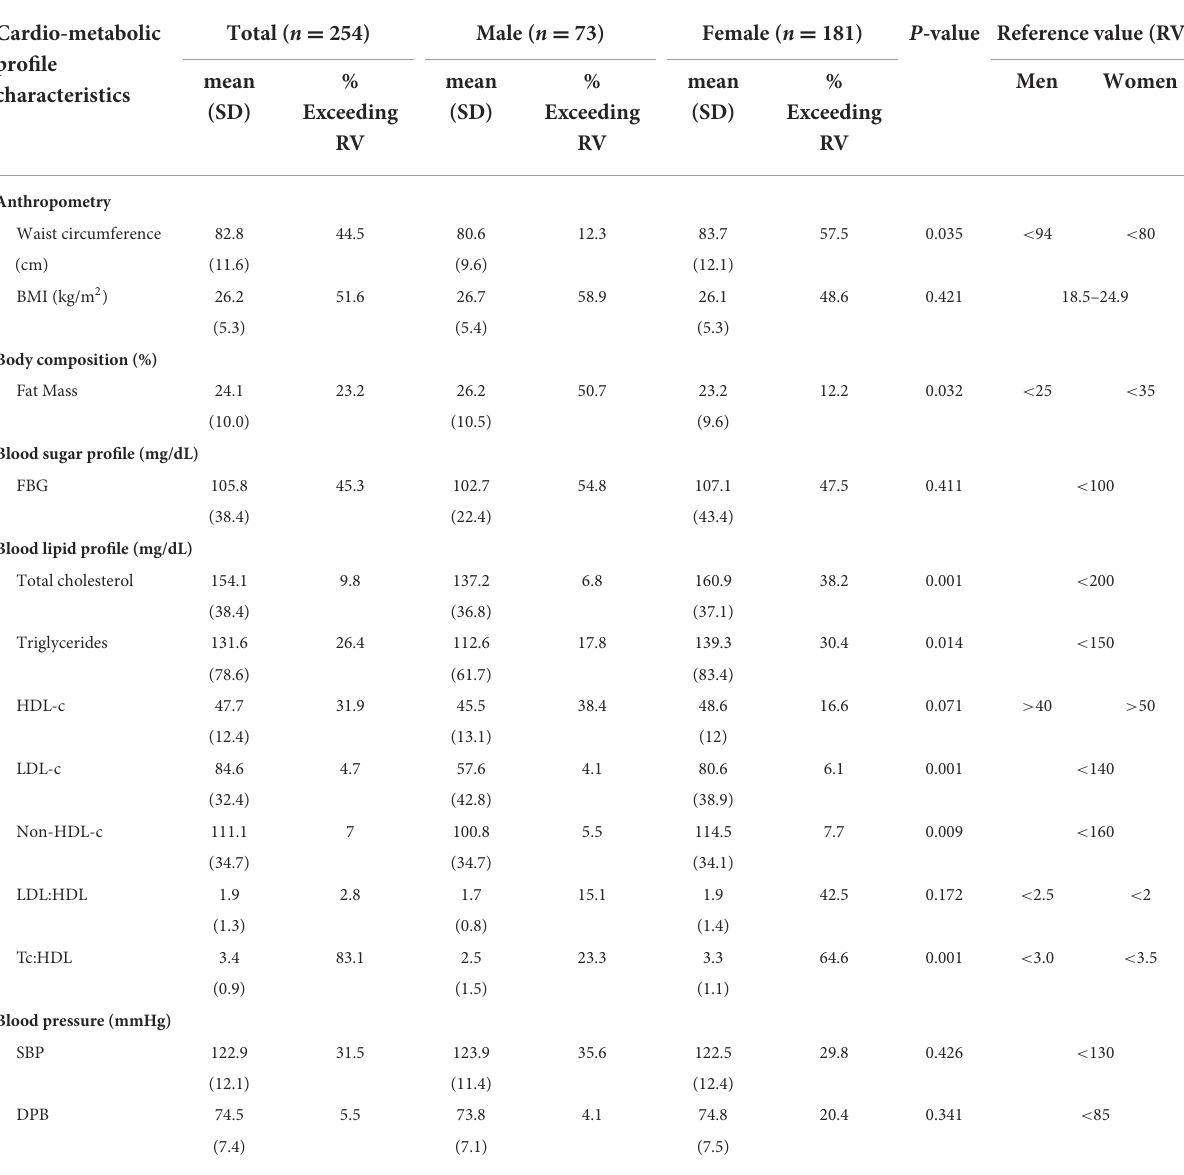
TABLE 2 Mean cardiometabolic profiles by sex. Cardio-metabolic profile